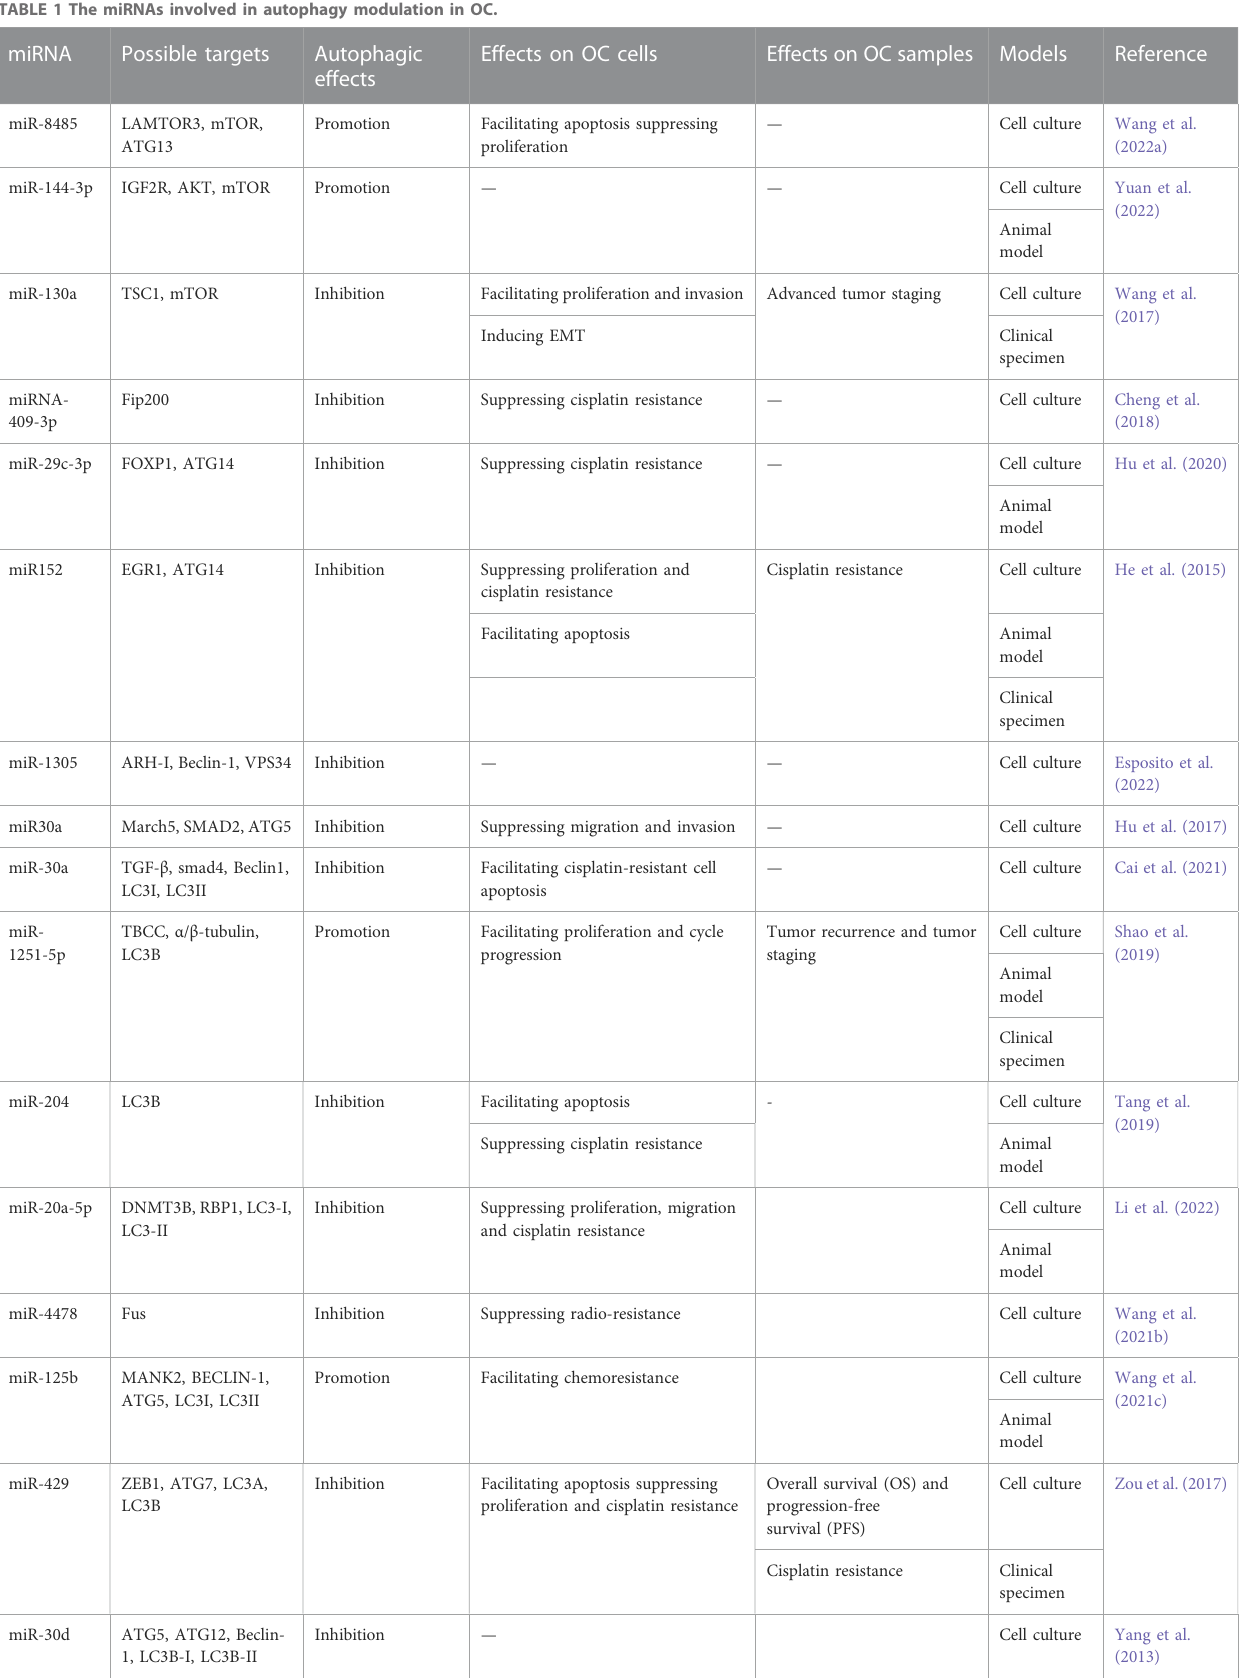
TABLE 1 The miRNAs involved in autophagy modulation in OC.